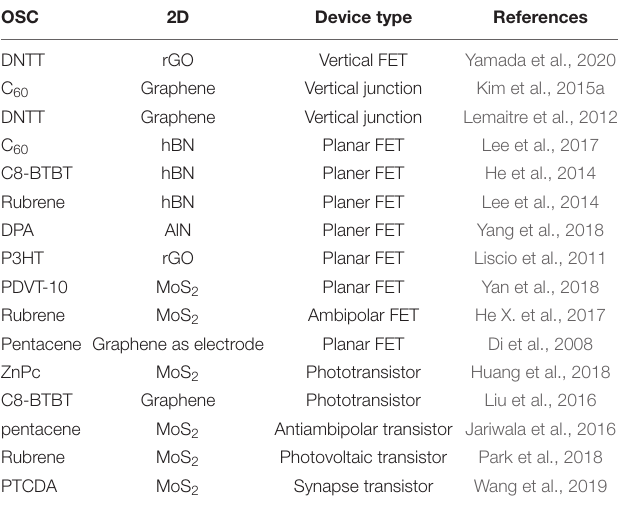
TABLE 1 | Typical OSC-2D hybrid structure that has been utilized in FET